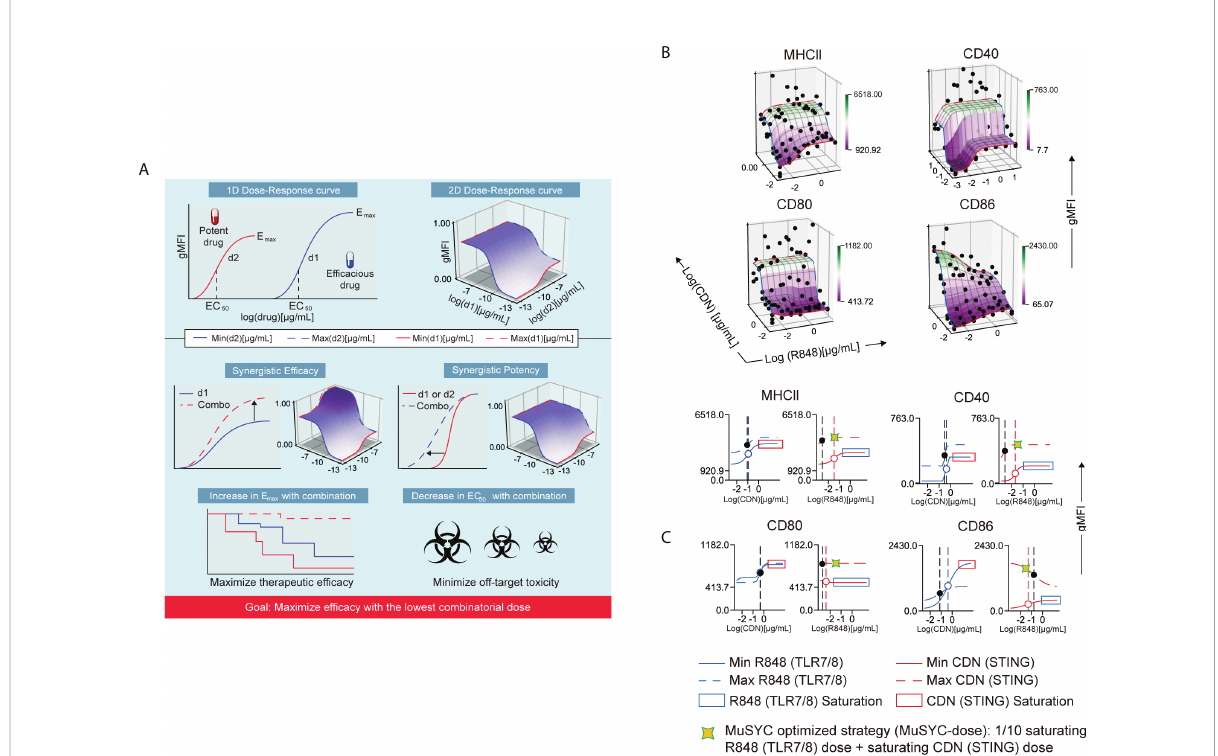
FIGURE 1 The combination of CDN and R848 is synergistically ef fi cacious and potent. (A) MuSyC algorithm classi fi cation scheme. (B) MuSyC algorithm- generated drug synergy diagrams for STING and TLR7/8 agonists activation of bone marrow – derived dendritic cells (mBMDCs). The y-axis is the log concentration of CDN (STING), the x-axis is the log concentration of R848 (TLR7/8), and the z-axis is the geometric mean fl uorescence intensity (gMFI) of multiple activation markers. Points are experimentally measured conditions. The surface is the fi t to the MuSyC equation, which quanti fi es the synergistic potency and ef fi cacy. The solid red line R848 single-agent dose-response. The solid blue line represents CDN single- agent dose-response. The blue dashed line is the max dose of R848 plus increasing amounts of CDN. The red dashed line represents the max dose of CDN plus increasing doses of R848. (C) One-dimensional graphs displaying an open circle for the EC 50 for the single agents and a solid black circle for the new EC 50 in the presence of the combinatorial agent. The vertical dashed lines represent the EC 50 of the respective curve. Optimization and derivation of the MuSyC-dose for the combination (1/10th saturating dose R848 and saturating dose